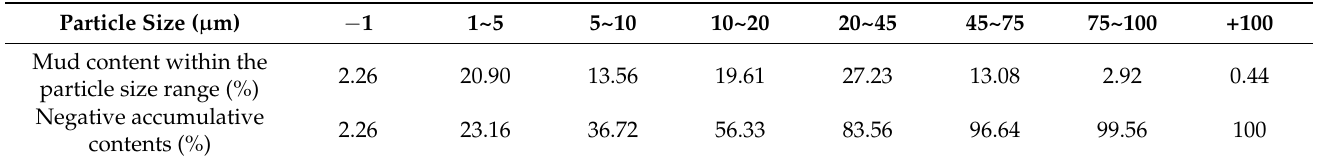
Table 3. Distribution of particle sizes of